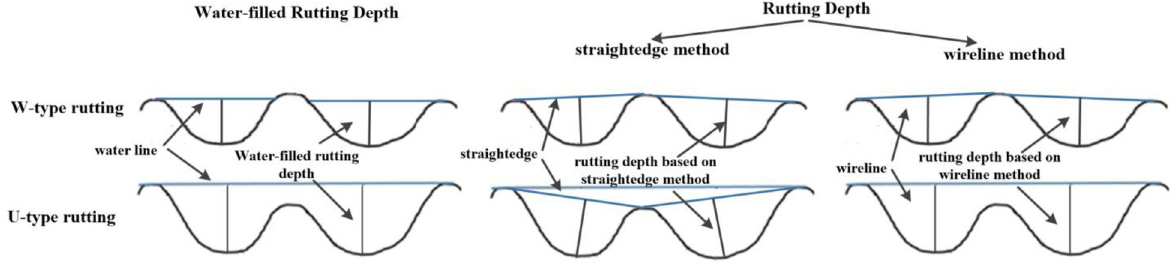
Fig 4. Rut parameters calculation methods.